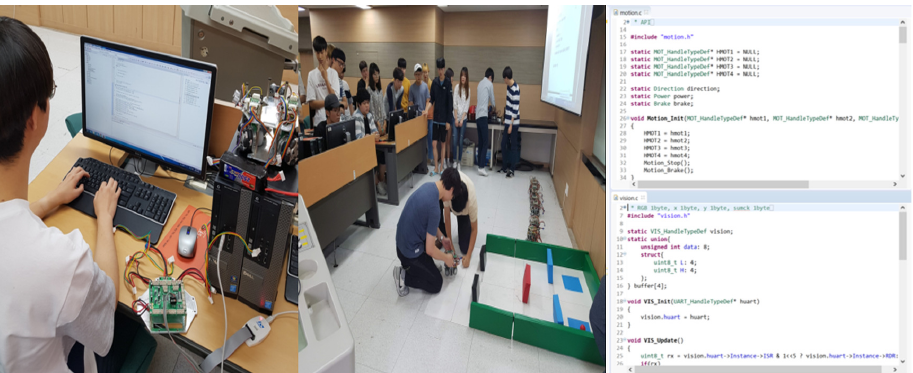
Figure 9. Participation activity in the Mechatronics class: ( left ) hands-on programming, ( middle ) project-based challenge, and ( right ) programming